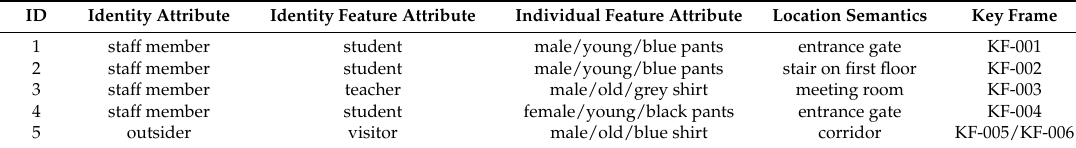
Table 2. The change semantics of the feature object in MVIndoorTrajectory.